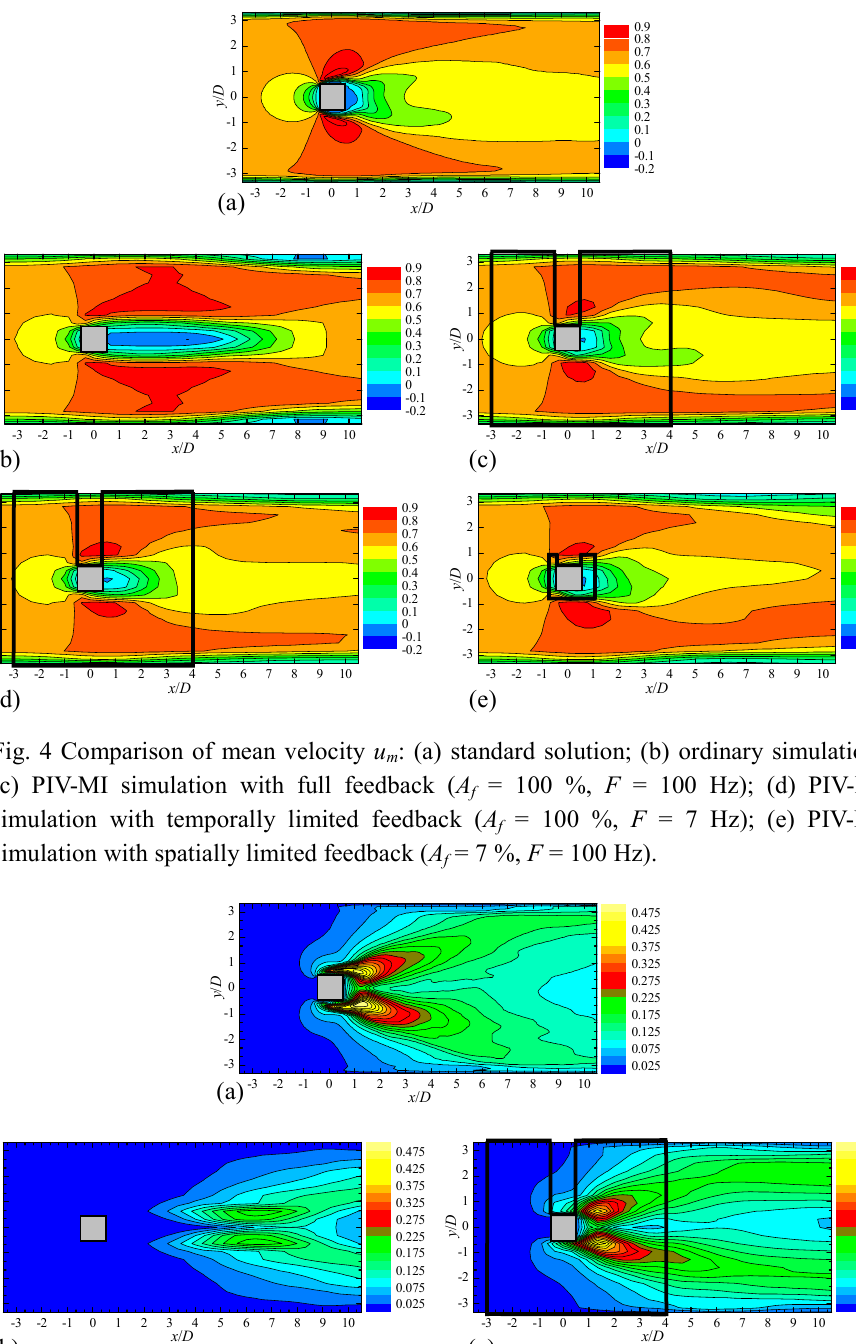
: (a) standard solution; (b) ordinary rms = 100 %, F = 100 Hz); (d) f = 100 %, F = 7 Hz); (e) PIV-MI f = 7 %, F = 100 f